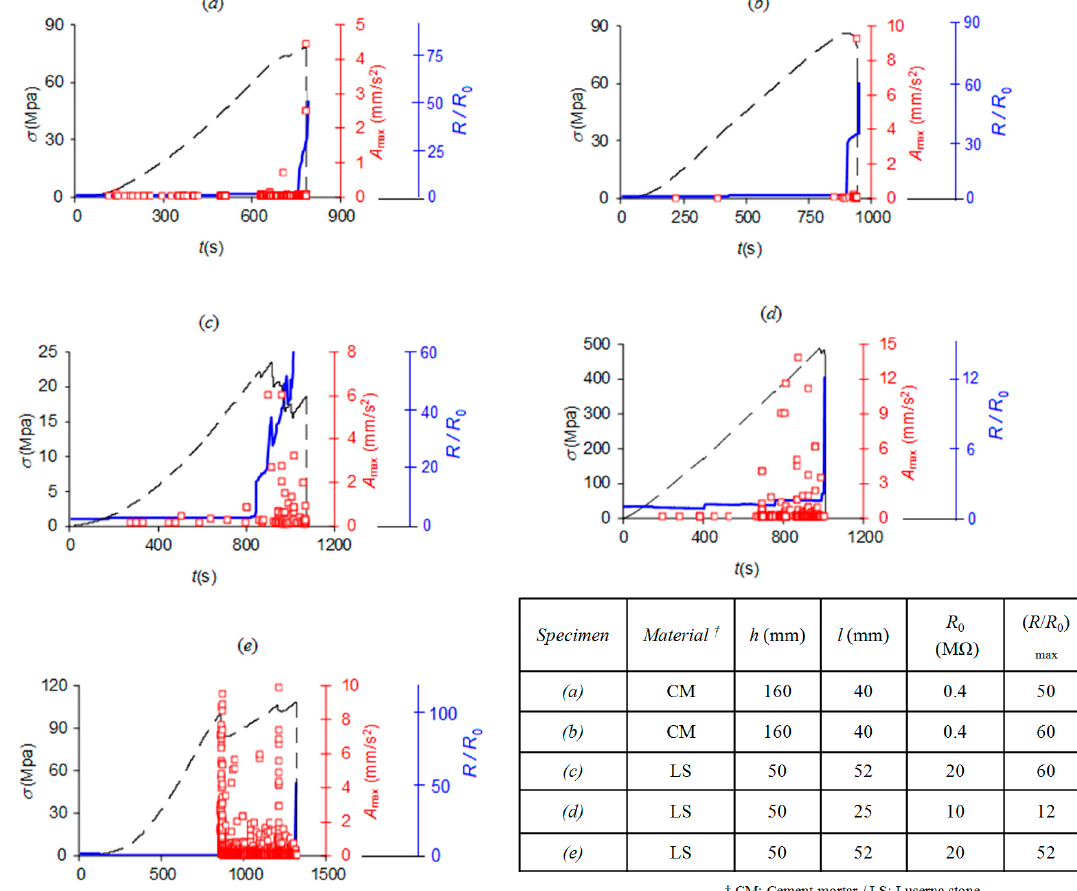
Figure 3. Variations over time of the applied stress (black dashed line), electrical resistance in R 0 units (blue solid line) and AE activity (red squares representing the peak acceleration of each AE event).